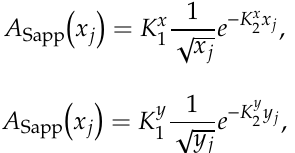
Figure 13. Dependencies of the maximum amplitudes A S ( x j , y i ) of the spectra of the measured signals versus distance: ( a ) wide edge (5 mm) scan direction, ( b ) narrow edge (1 mm) scan direction.